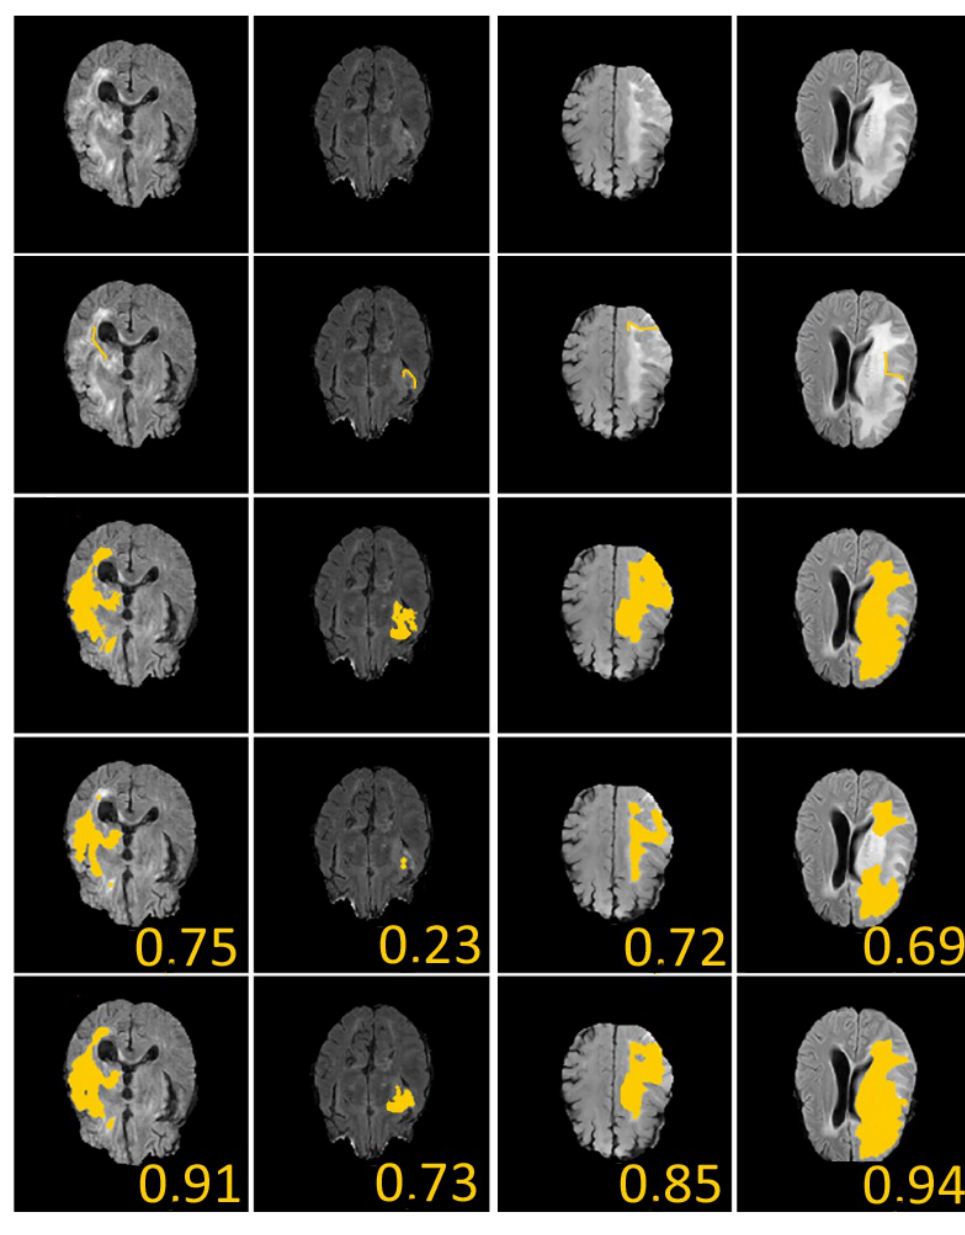
Figure 8. Brain Tumor Segmentation (using BRATS dataset [28]). Several results from our method using labeled data on the BRATS dataset [28]. The tumor is underlined in yellow. First row: center slices of input. Second row: initial conditions for our algorithm. Third row: ground-truth labels. Fourth row: results from the supervised U-Nets learning method introduced by Ronnenberger et al. [27]. Fifth row: results from our proposed method. The scores in the bottom of each results denote Dice score.